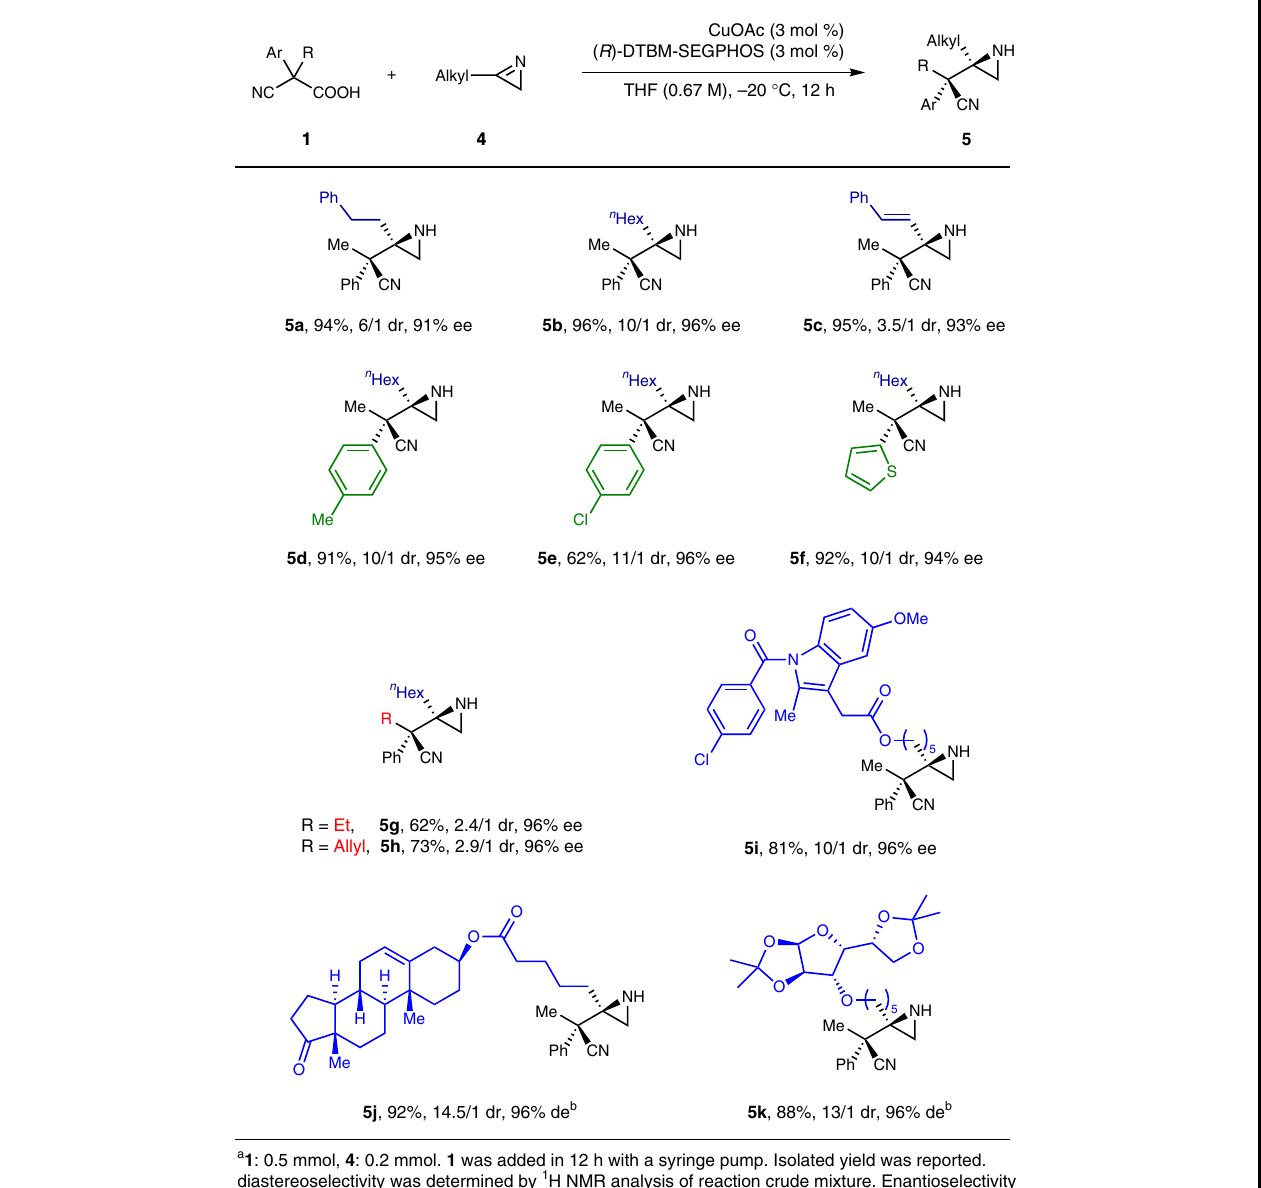
Table 3 Substrate scope of aliphatic 2 H -azirines a